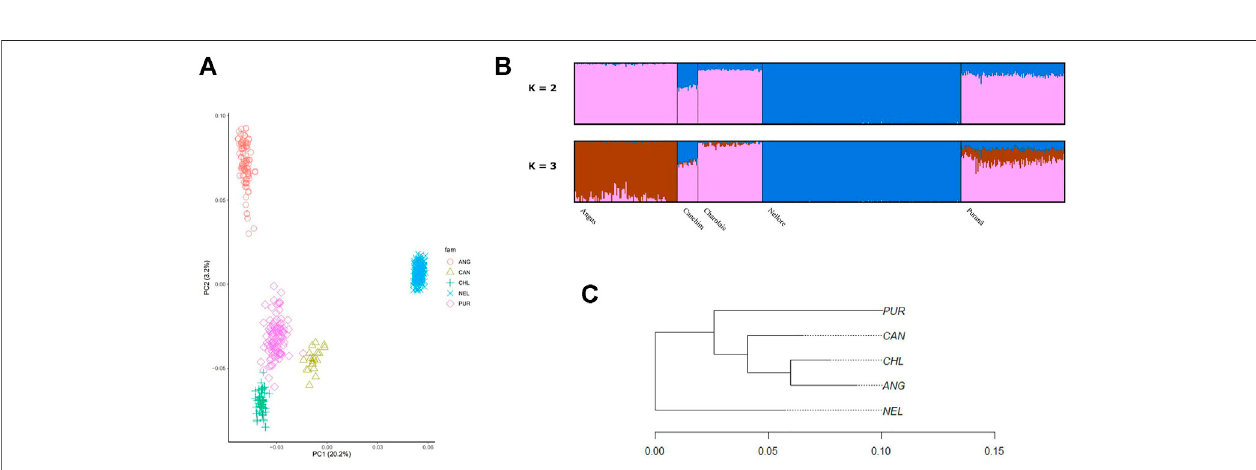
FIGURE2 | Population strati fi cation ofthe Purunã breed. (A) Principal component analysis (PCA) including Purunã, Angus, Canchim, Charolais, and Nellore breed animals. (B) Admixtureanalysis ofPurunã, Angus, Canchim, Charolais, and Nellore breeds. (C) Phylogenetic treeusing Reynold ’ s distancefor the Purunã (PUR), Angus (ANG), Canchim (CAN), Charolais (CHL), and Nellore (NEL) populations.